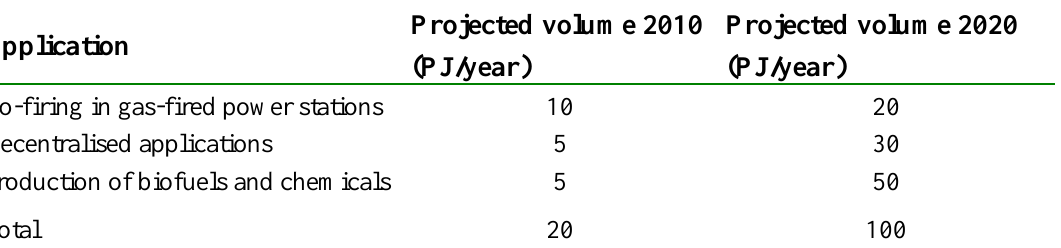
Table 1. Projected use of gasified biomass in the